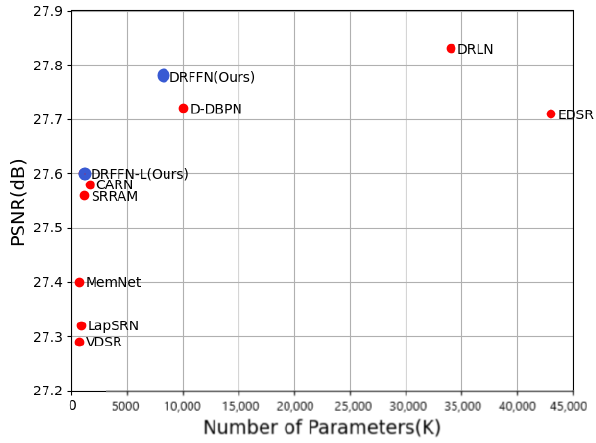
Figure 8. PSNR vs. Parameters on BSD100 (×4).